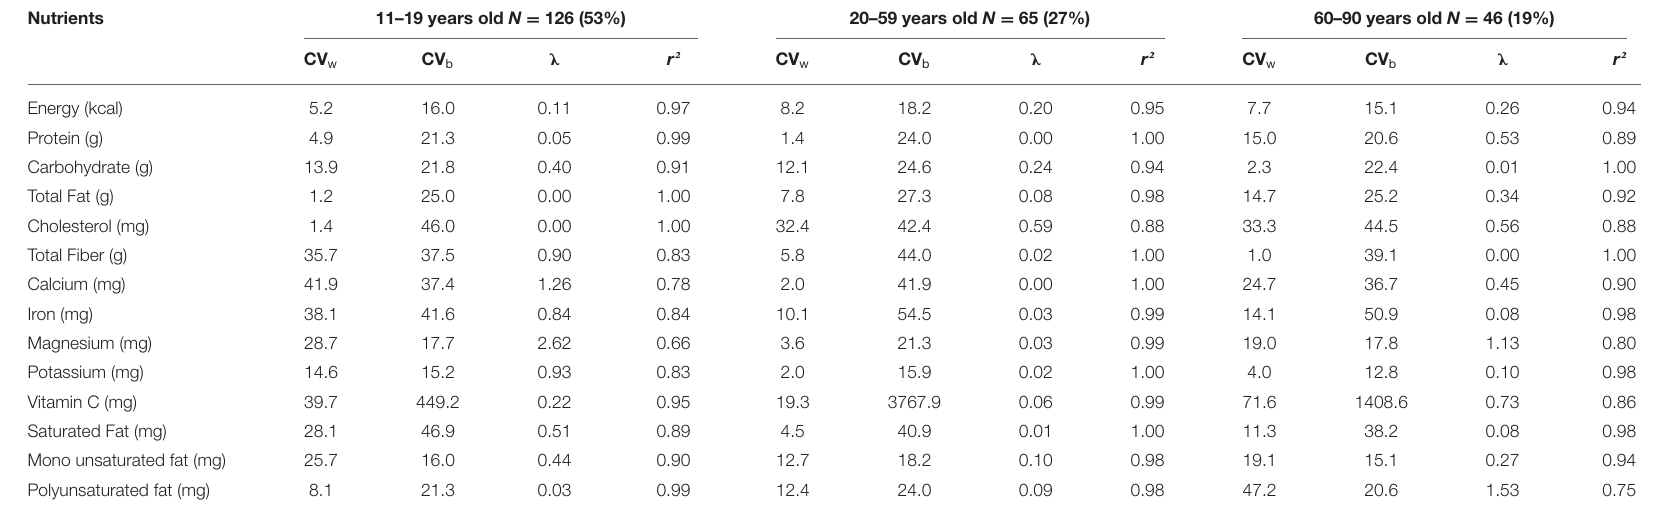
TABLE 3 | Coefficient of variation within person (CV w ) and between person (CV b ), variance ratio ( λ ), and correlation between observed and usual energy and nutrients’ intake ( r ² ) by age.